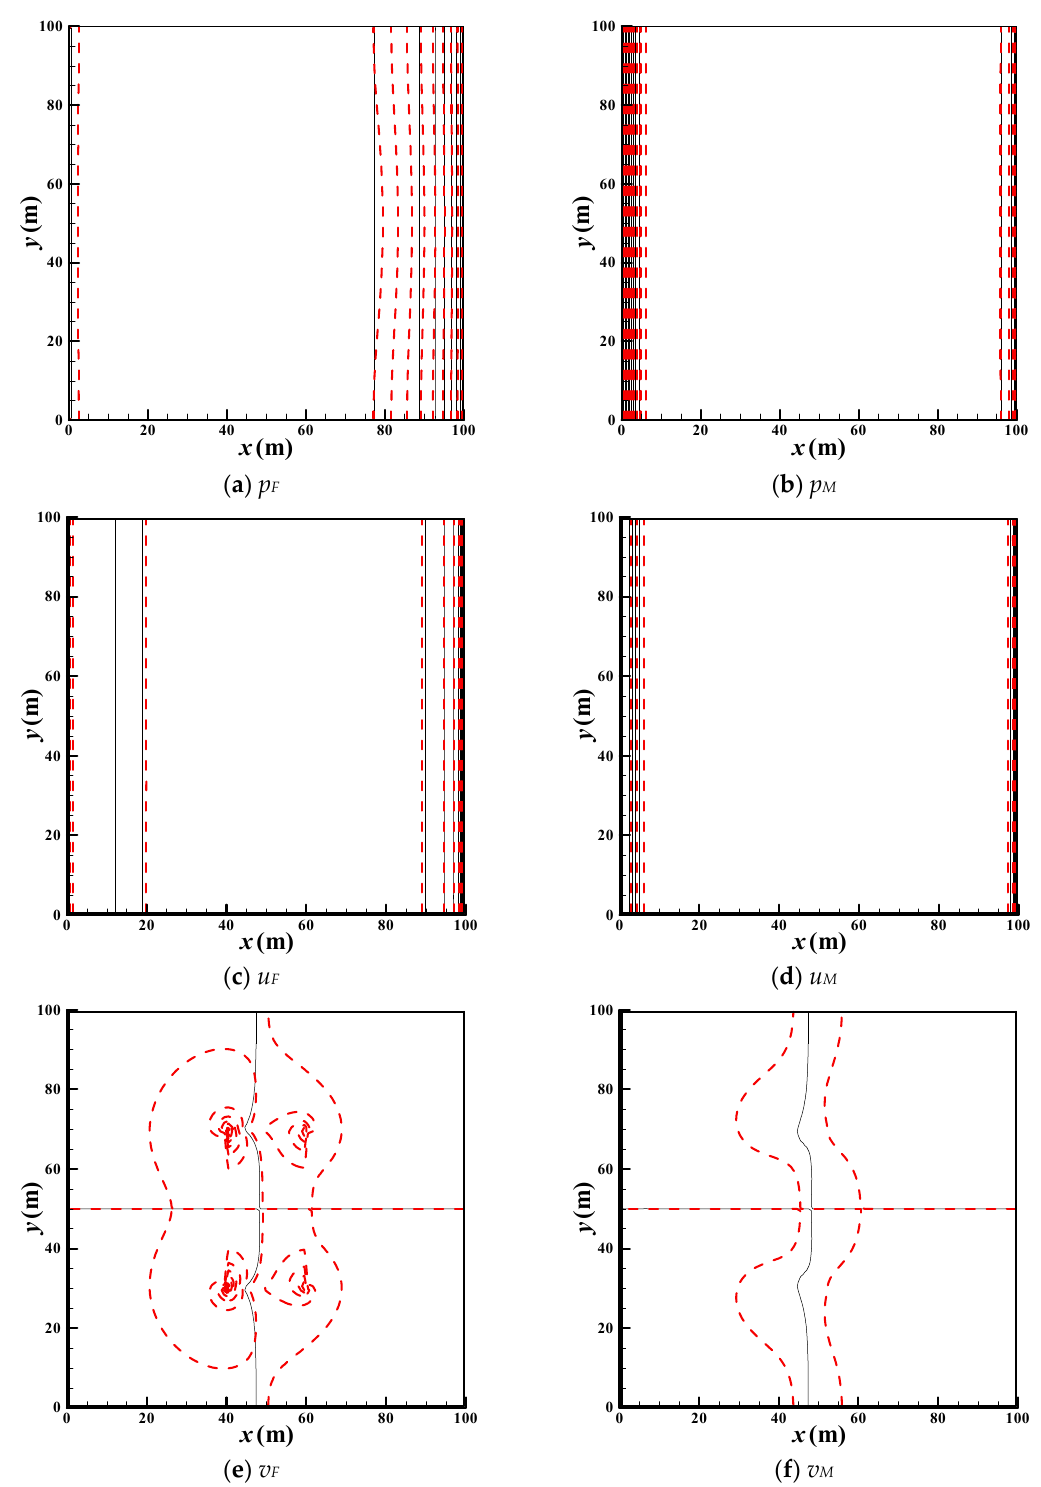
Figure 8. Flow field comparison for matrix and fracture at 0.15 days: black solid line-FDM; red dashed line-POD ( ε F = 2.84%, ε M =